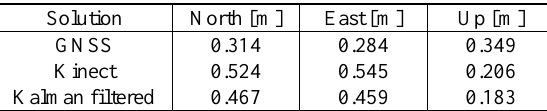
Table 6. Standard deviations between the computed solutions for the downsampled scenario and the reference trajectory measured with the